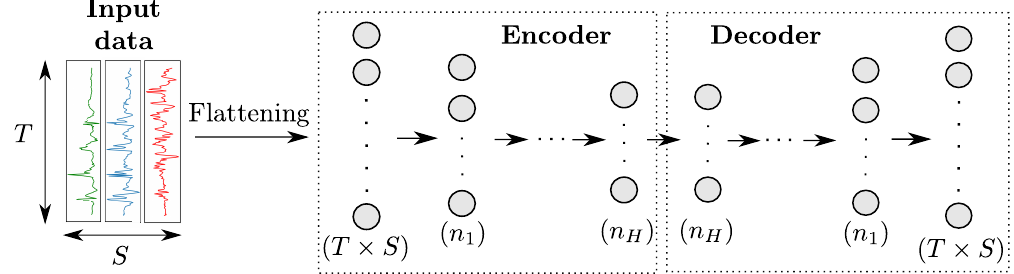
Figure 7. Architecture of an autoencoder model for sensor-based HAR. The numbers in parenthesis refer to the number of neurons per layer. H denotes the number of hidden layers in both the encoder and